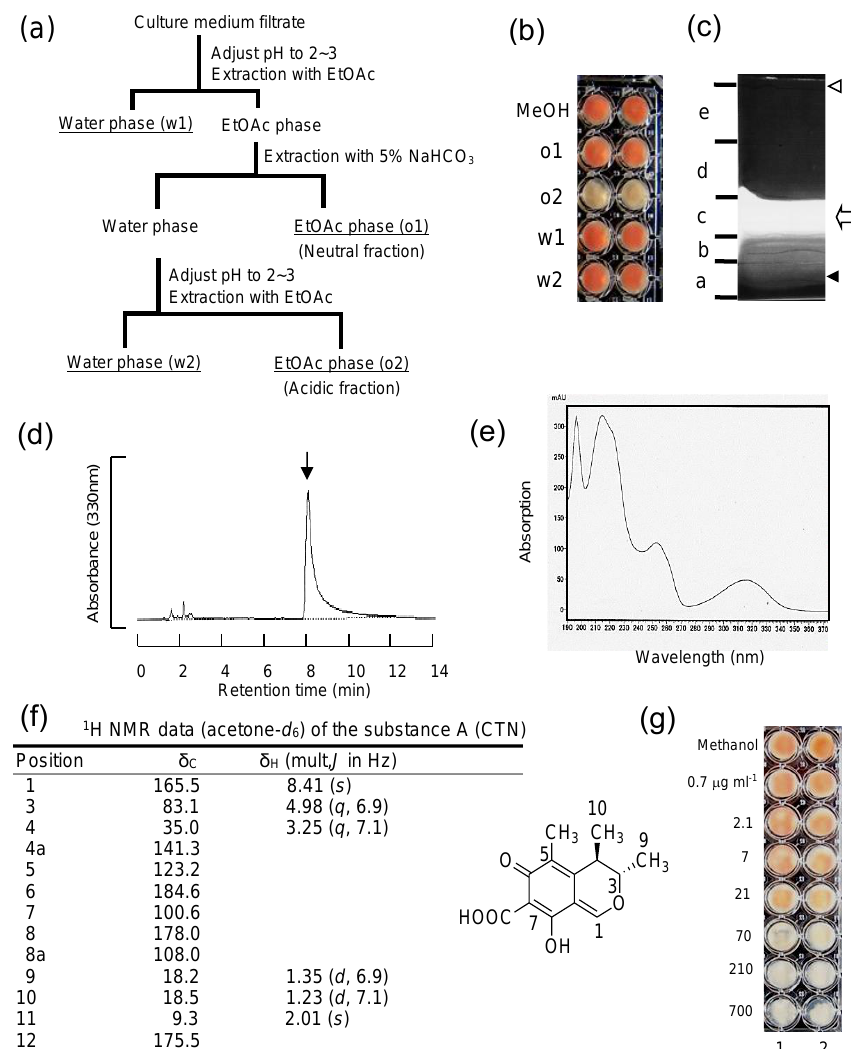
Figure 2. The purification of substance A from P. citrinum NFRI-MI190 culture medium: ( a ) The filtrate of the culture medium was fractionated at various conditions by organic solvent; ( b ) the inhibitory activity of each fraction (o1, o2, w1, and w2) was examined in a microtiter plate assay, showing that the inhibitory substance(s) was present in the o2 fraction; ( c ) the o2 fraction was analyzed by TLC. The inhibitory activity was observed at the c part, which showed bright yellow fluorescence (open arrow) (origin of the spot (closed triangle), front of the developing solution (open triangle)); liquid chromatography result ( d ) and the absorption spectrum ( e ) of the extract of the c part by the LC-APPI-MS analysis are shown; ( f ) the 1 H NMR data (acetone- d 6 ) and the structure of substance A; ( g ) microtiter plate assay using various concentrations of the purified substance A (lane 1) or the authentic standard of CTN (lane 2).